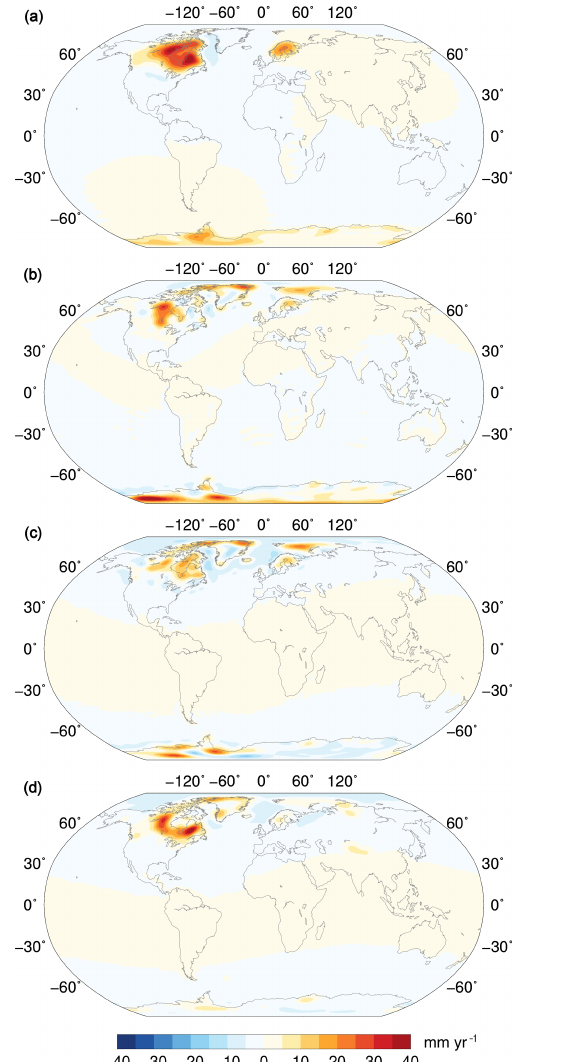
Figure 5. (a) Ensemble GIA solution in terms of equivalent water height; (b–d) difference between three published GIA models and the ensemble solution (mmyr − 1 e.w.h.): (b) A et al. (2013) – en- semble; (c) Peltier et al. (2015) – ensemble; (d) Caron et al. (2018) –